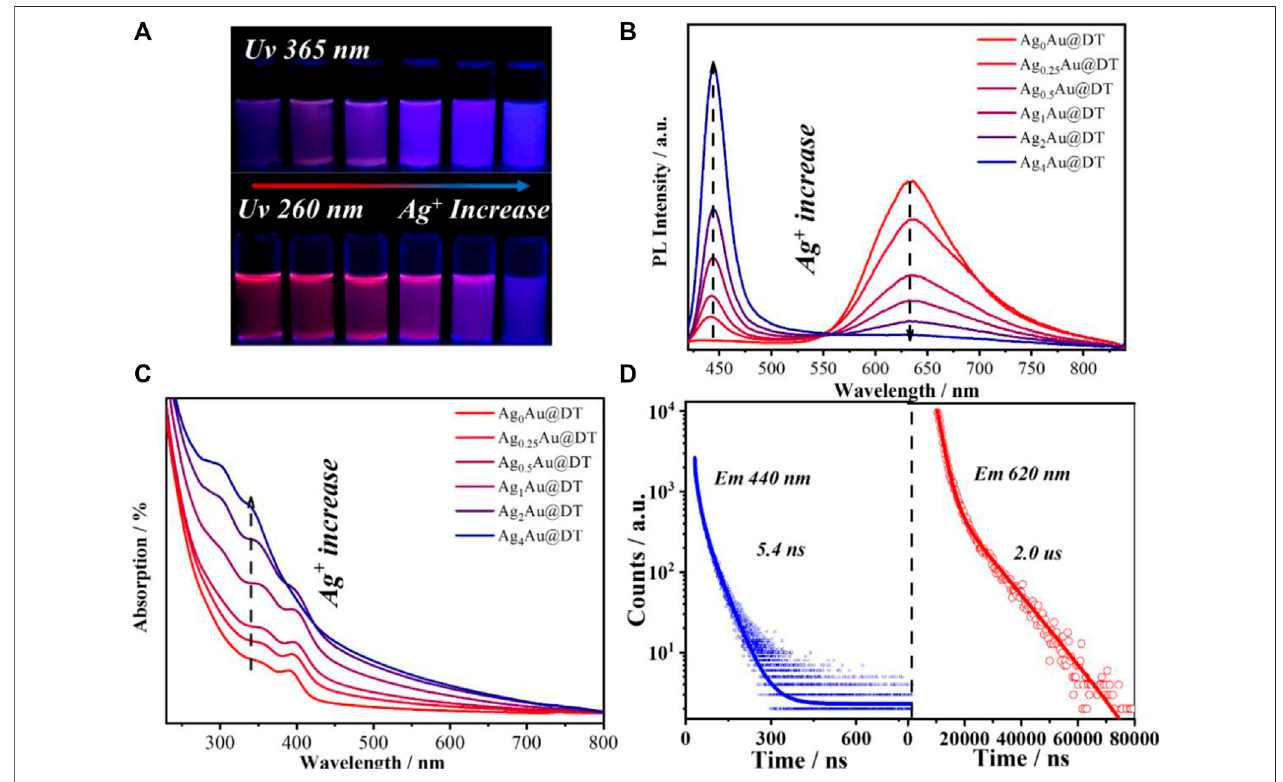
FIGURE1|(A) LuminescentphotographsofAg x Au@DTNCsunderUV365 nm (top) and260 nm (bottom) irradiations.Photoluminescenceemissionspectra (B) and absorption spectra (C) of Ag x Au@DT NCs. (D) Time-resolved luminescence decay pro fi les of Ag 1 Au@DT NCs measured at 440 nm (left panel) and 630 nm (right panel) , respectively.